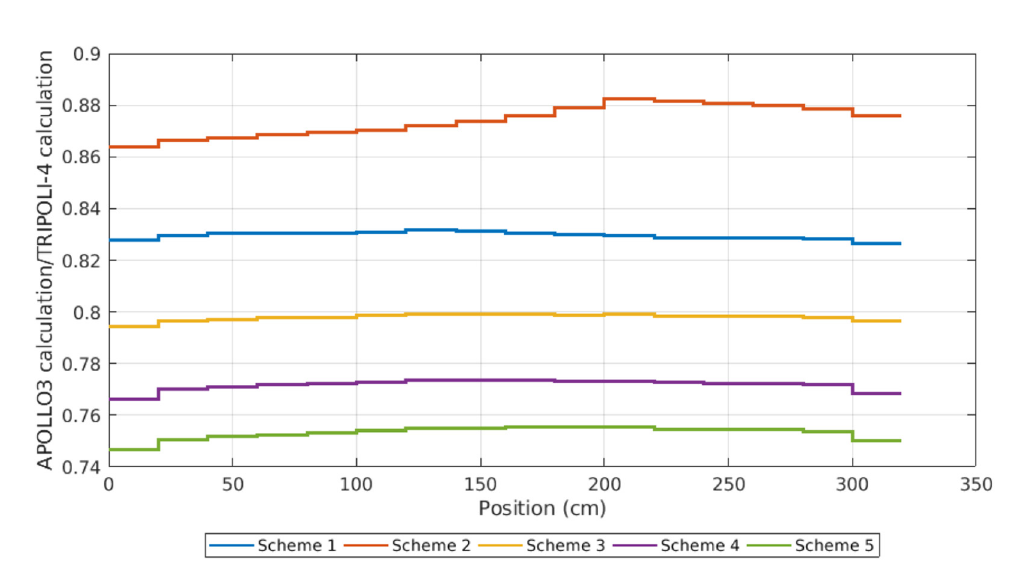
Fig. 30. Deterministic-stochastic comparison on the activation rate inside the internal heat exchanger.